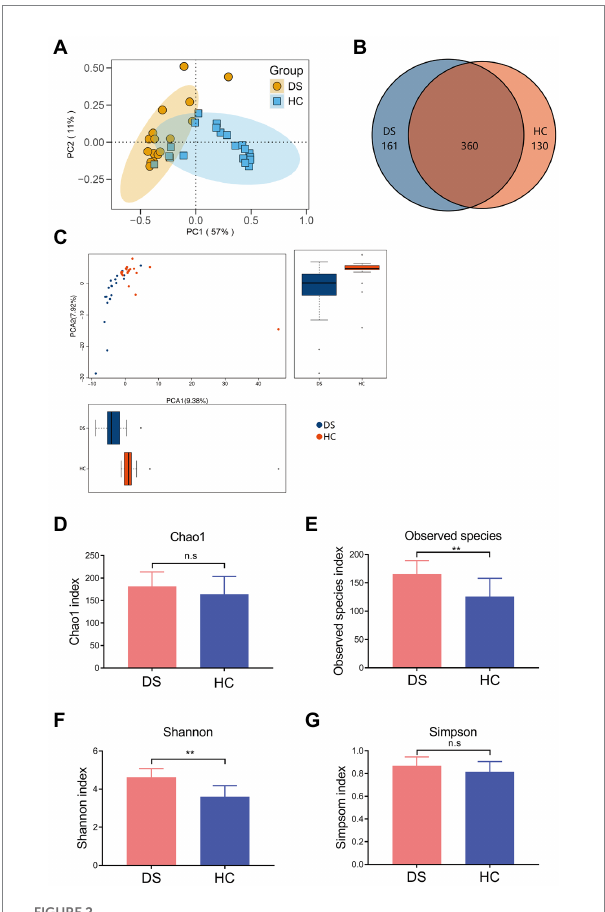
FIGURE 2 Differences in the intestinal microbiota composition and diversity in the non-DS and DS groups. 16S rRNA sequencing data was used to assemble operational taxonomic units (OTUs). (A) PCA plot of intestinal flora. (B) Venn diagram of intestinal microbiota. (C) Analyses of intestinal flora based on OTUs. (D–G) Alpha diversity was used to assess the flora diversity and distribution, including the Chao1 index (D) , observed species index (E) , Shannon index (F) , and Simpson index (G) . ** A significant difference ( p < 0.01) in the observes species of intestinal microbiota was seen in individuals with DS and non-DS volunteers. HC, non-DS volunteers (or non-DS group); DS, individuals with DS (or DS